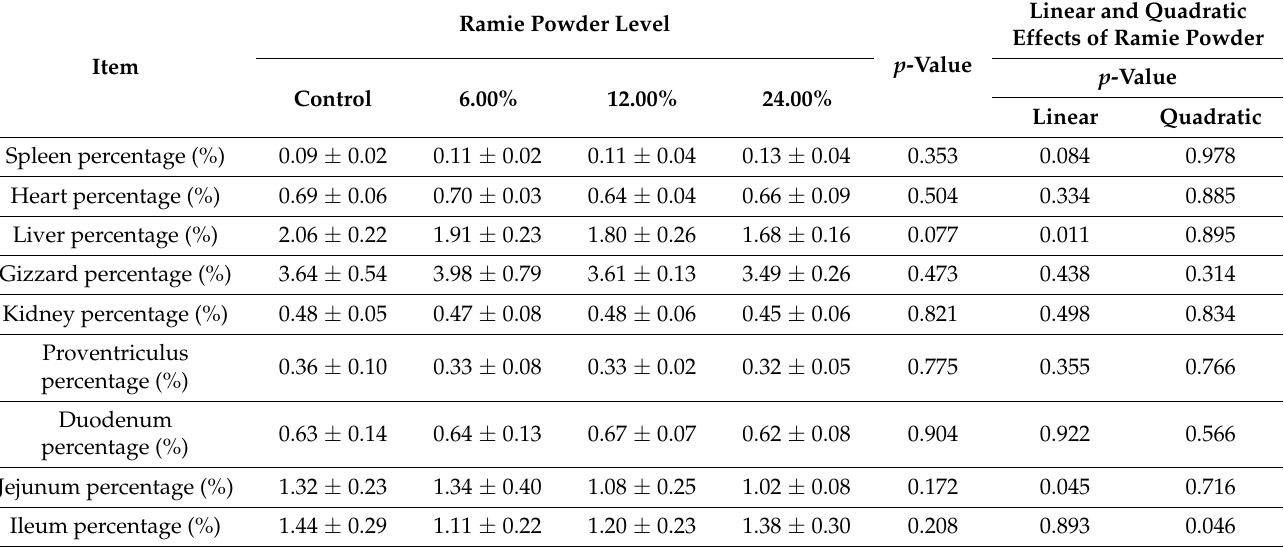
Table 3. Effect of the different ramie powder levels in the diets on the proportion of the organs compared to the body weight of the Yanling white geese (56–98